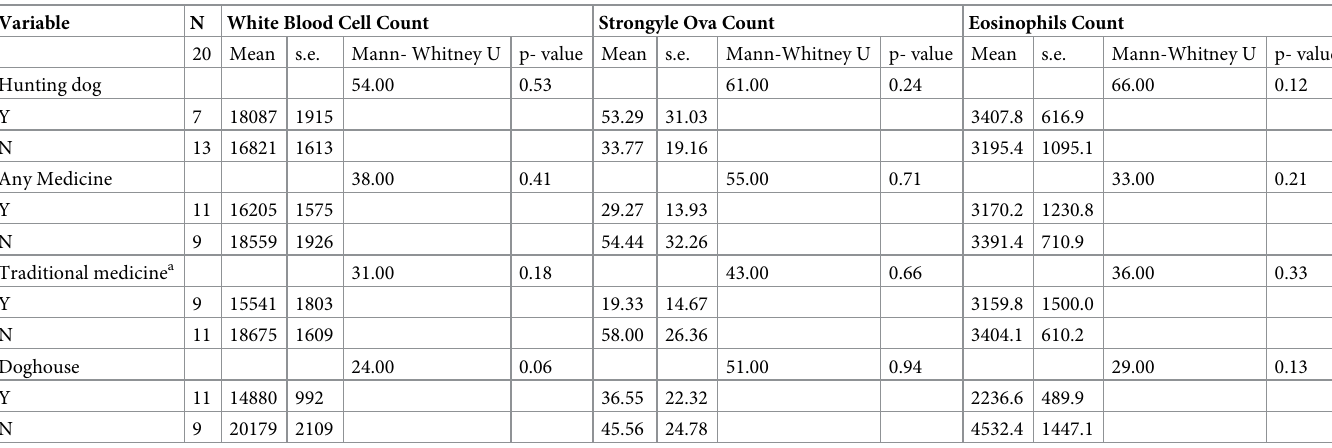
Table 4. Comparison of white blood cell, strongyle ova, and eosinophil counts across four independent variables predicted to be associated with Waiwai dog health.